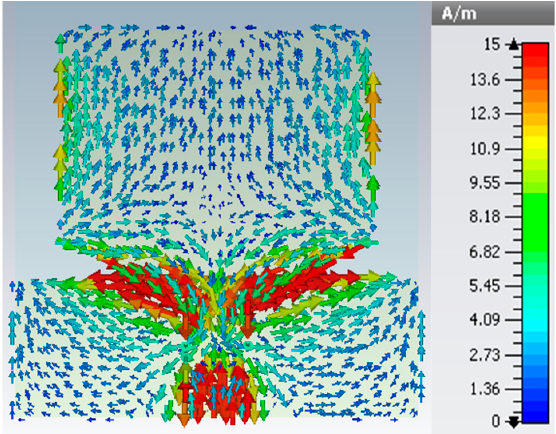
Figure 6. Surface current distribution in 8.15 GHz at 42% concentration of nickel.